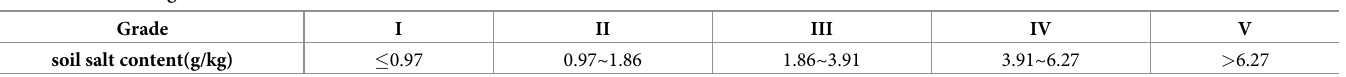
Table 1. Salinization grade